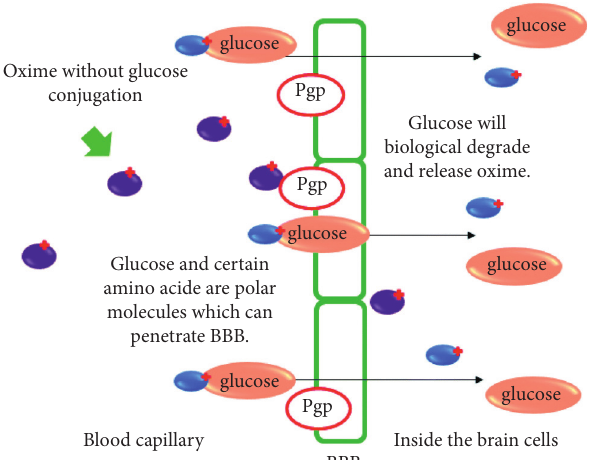
Figure 7: Schematic diagram of BBB penetration of glucose-conjugated oxime. The picture was adapted from